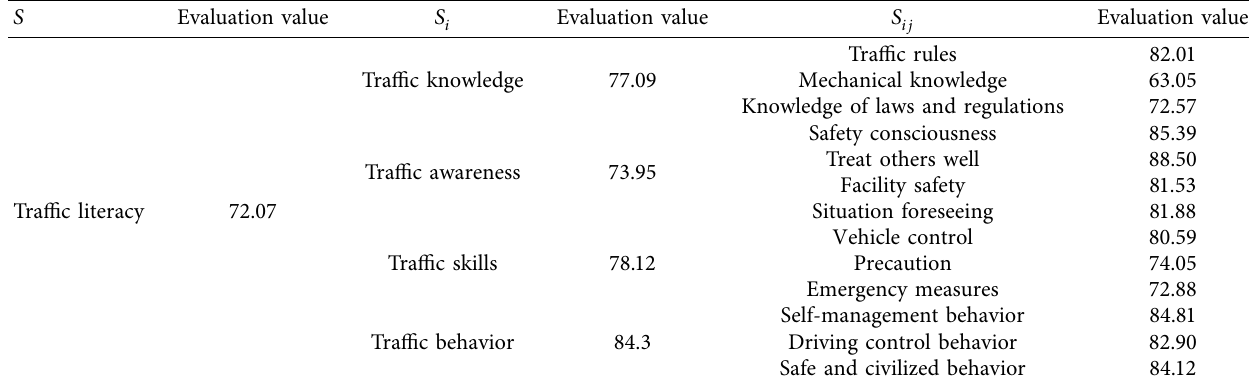
Table 10: Zhengzhou city motor vehicle driver traffic literacy evaluation